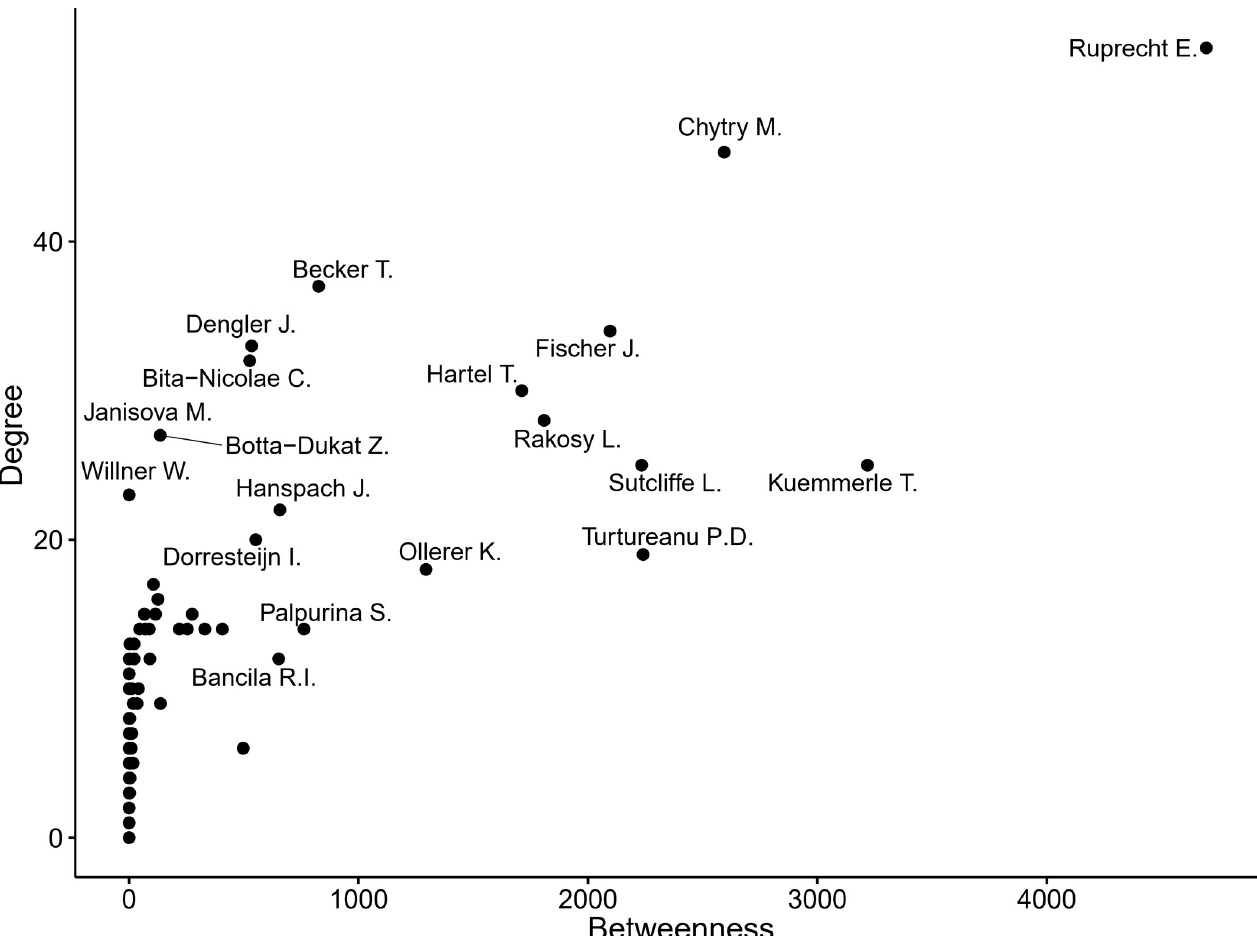
Fig 7. Top academic authors publishing work about Romania’s grasslands by degree and